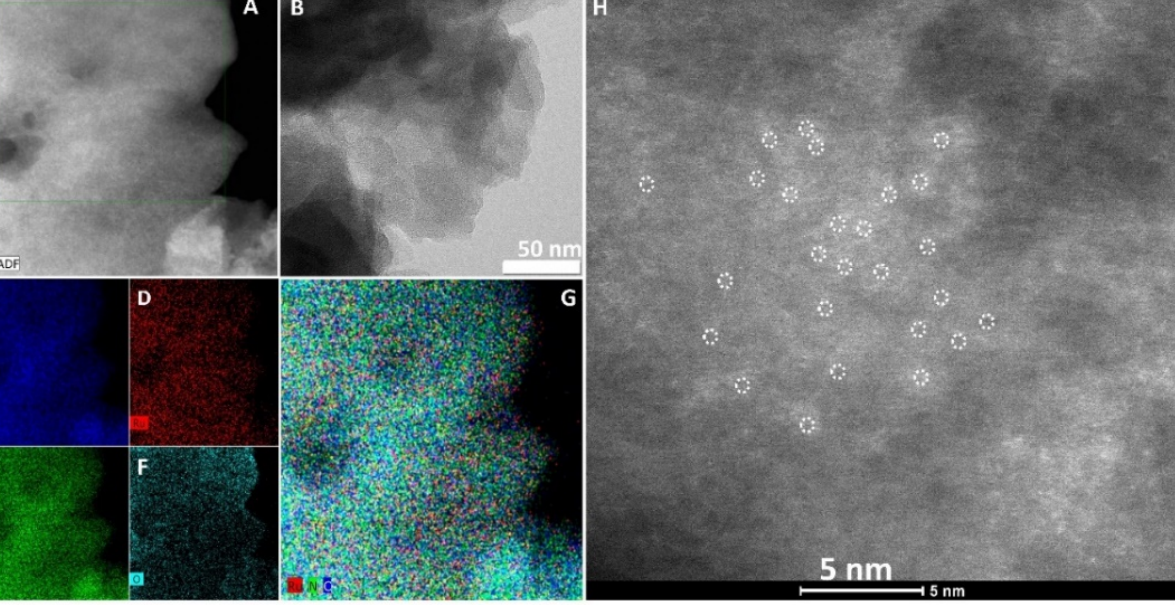
Figure 2. HR-TEM analysis of SRu-mC 3 N 4 : ( A ) HAADF-STEM elemental mapping images showing O, N, Ru, and C individually ( C – F ) and ( G ) Ru, N, and C together (scale: 40 nm); ( B ) TEM image at 50 nm; and ( H ) HR-TEM image at 5 nm exhibiting the ruthenium single atom existence over mC 3 N 4 support.